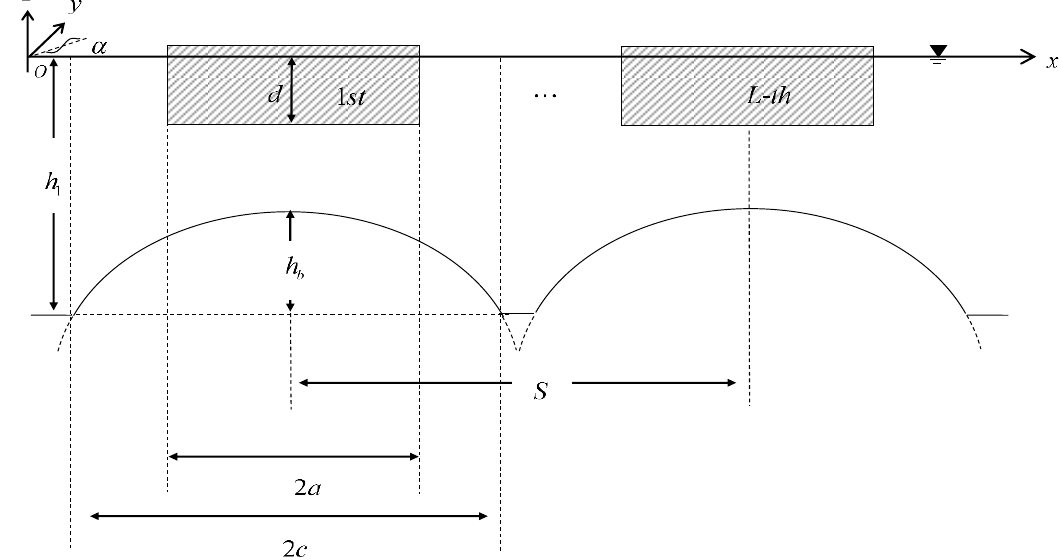
Figure 10. Schematic diagram of Bragg reflections by periodic rectangular surface-piercing structures over periodic parabolic breakwaters.